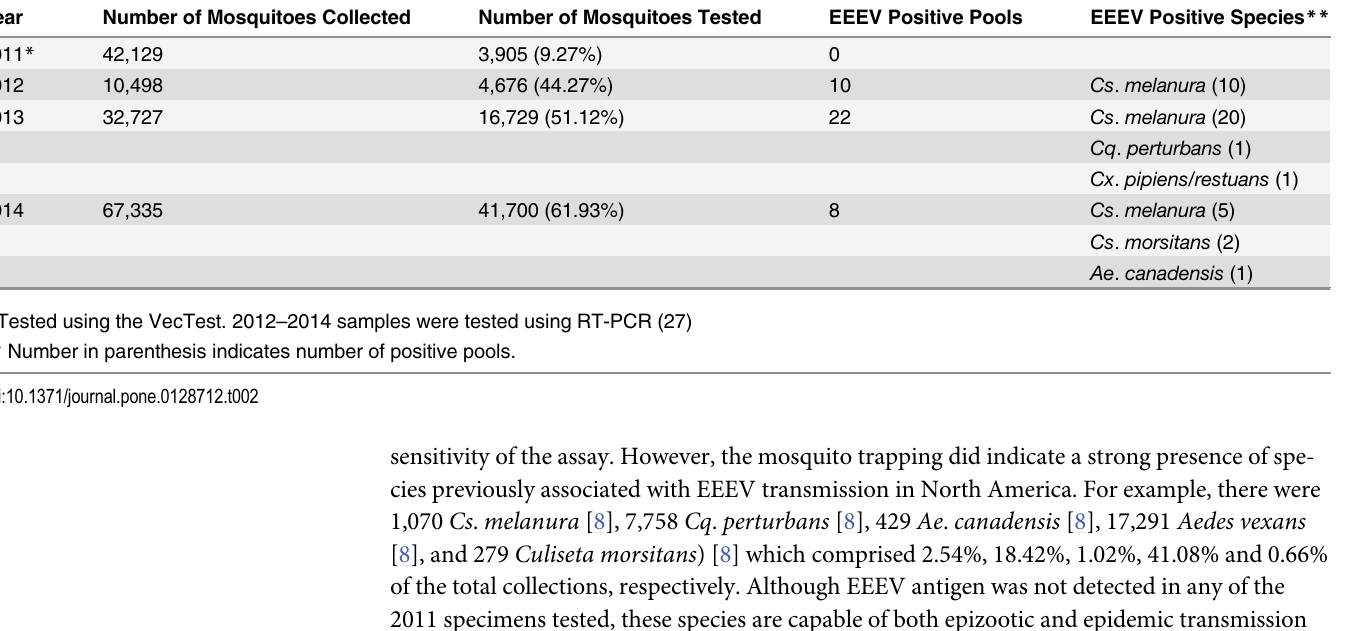
Table 2. The number and percentage of mosquitoes collected and screened for EEEV in Vermont from 2011 to 2014.